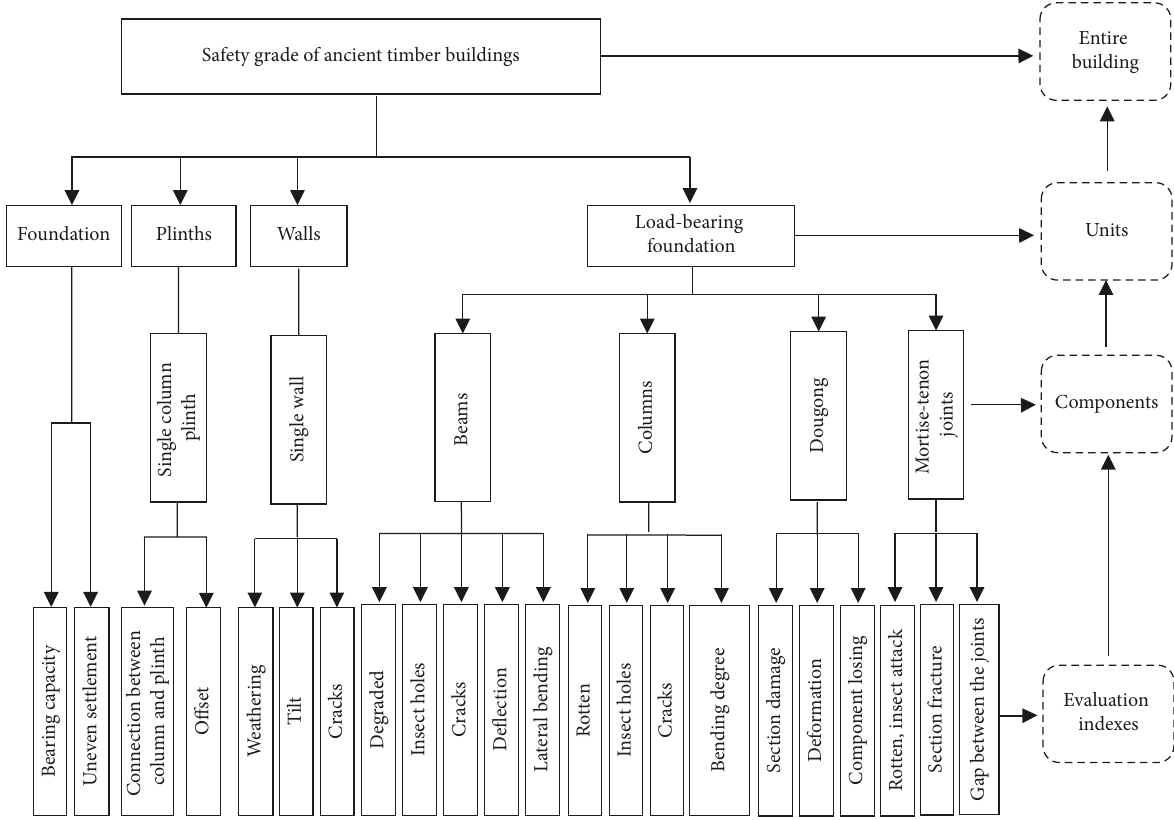
Figure 1: Safety grade evaluation system of ancient timber building. Table 2: Safety grade classification for wood beam, Fang, and purlin.